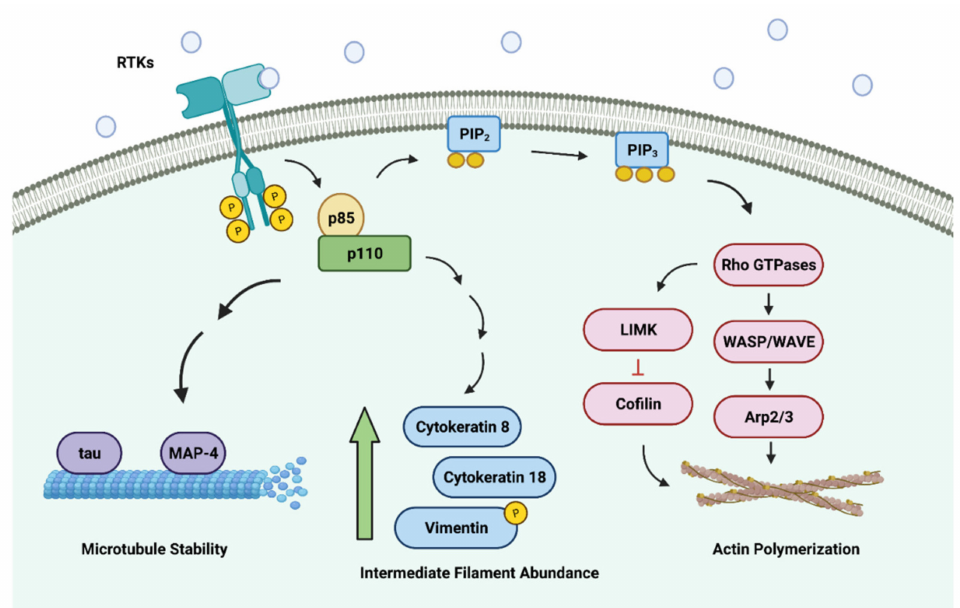
Figure 3. PI3K/AKT signaling axis regulates all major classes of cytoskeletal components. The activation of the PI3K/AKT signaling pathway plays key roles in the assembly of nascent actin filaments, polymerization of microtubules, and abundance of intermediate filaments. Collectively, these changes enhance the motility and migratory potential of cancer cells. Image created with BioRender.com (accessed on 14 February